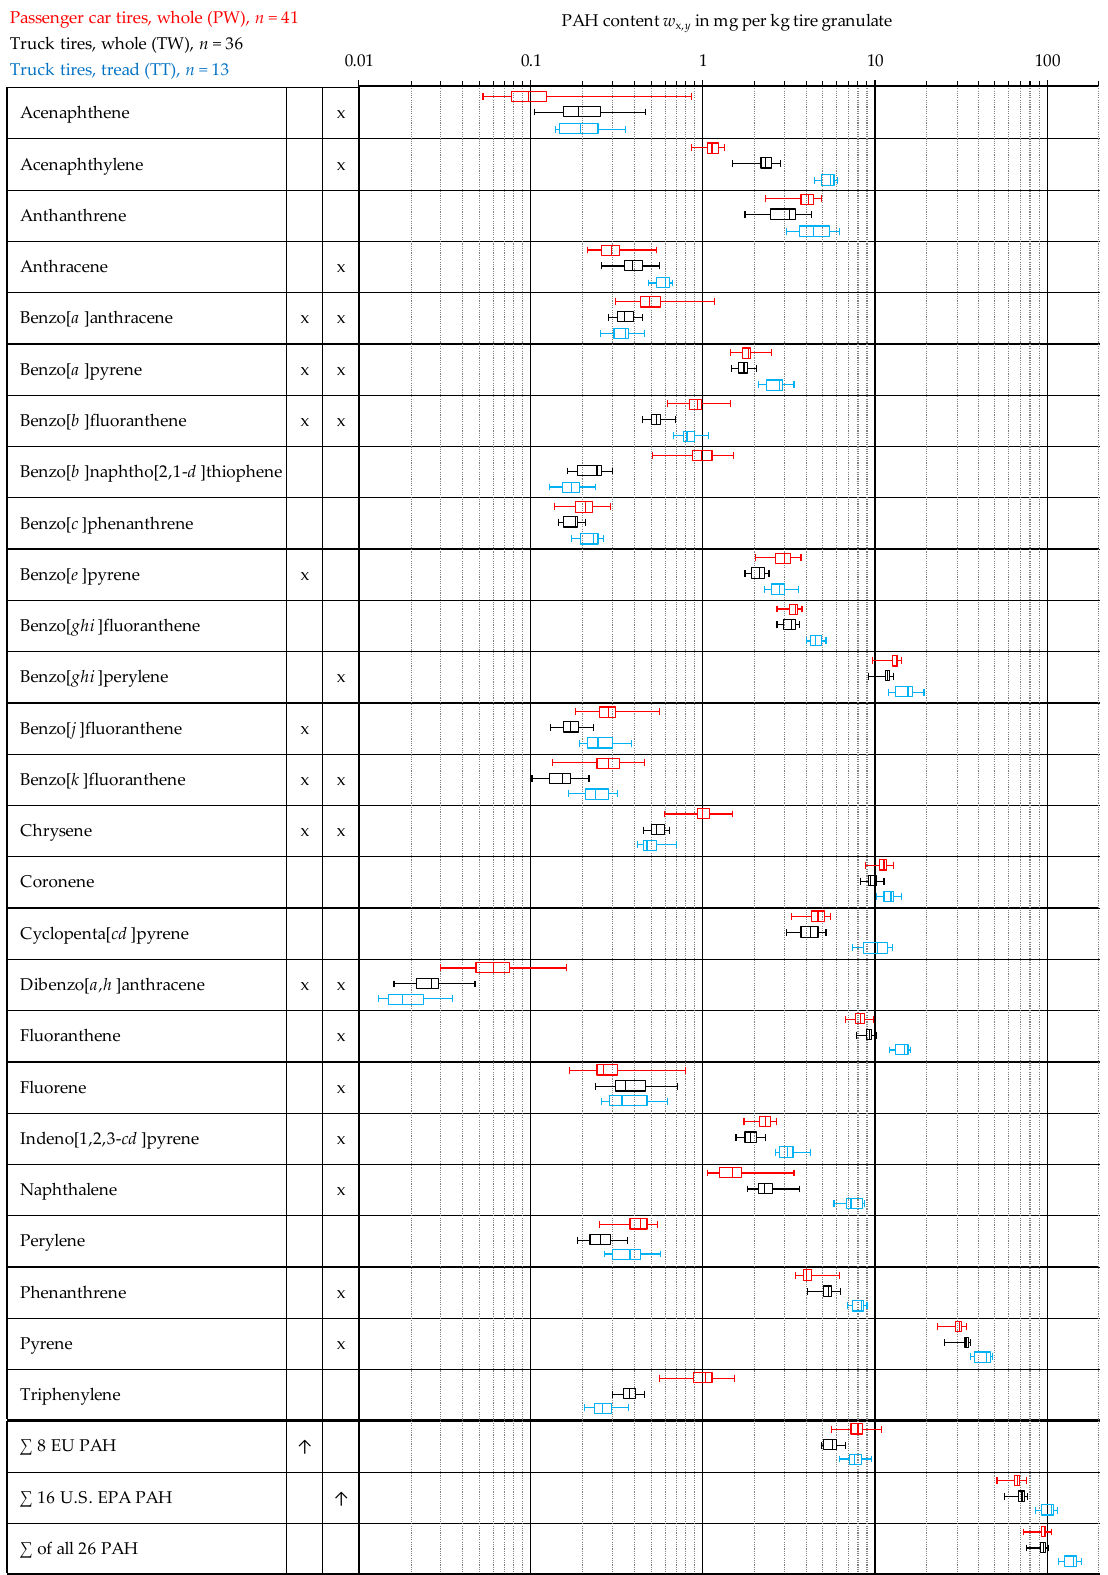
Figure 3. Measurement data distribution of the entire measurement series for all three materials investigated. For truck tire treads, the results of the triple measurement of buffings were not taken into account.